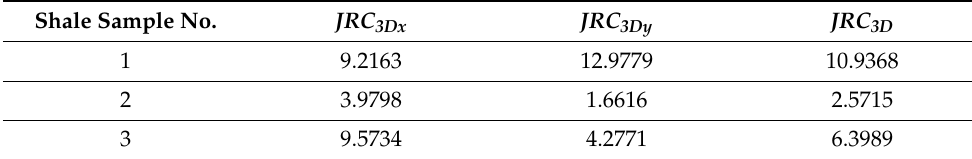
Table 2. JRC 3D of shale fracture surface